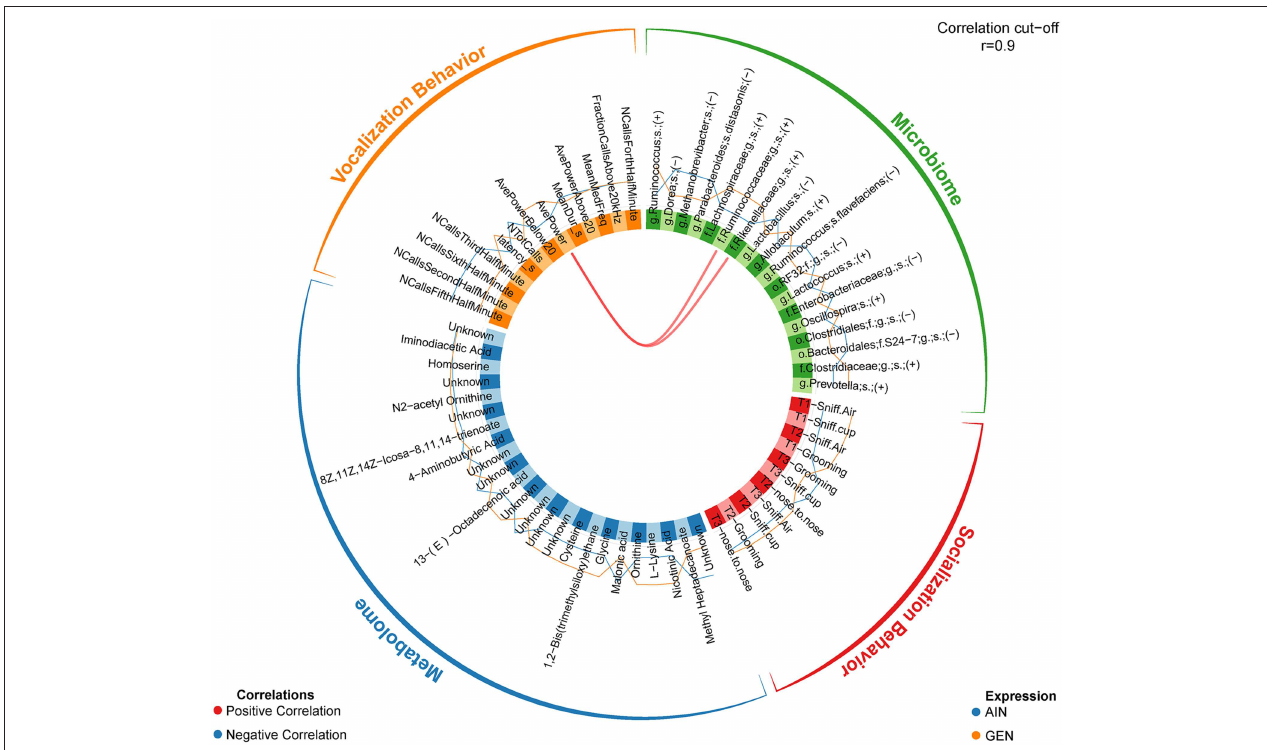
FIGURE 3 | Circos correlations as determined with mixOmics analyses (72) for behavioral responses, gut microbiome, and gut metabolome changes in GEN exposed females vs. AIN (control) female California mice. Adapted from Marshall et al. ( 46) with permission from BioScientifica